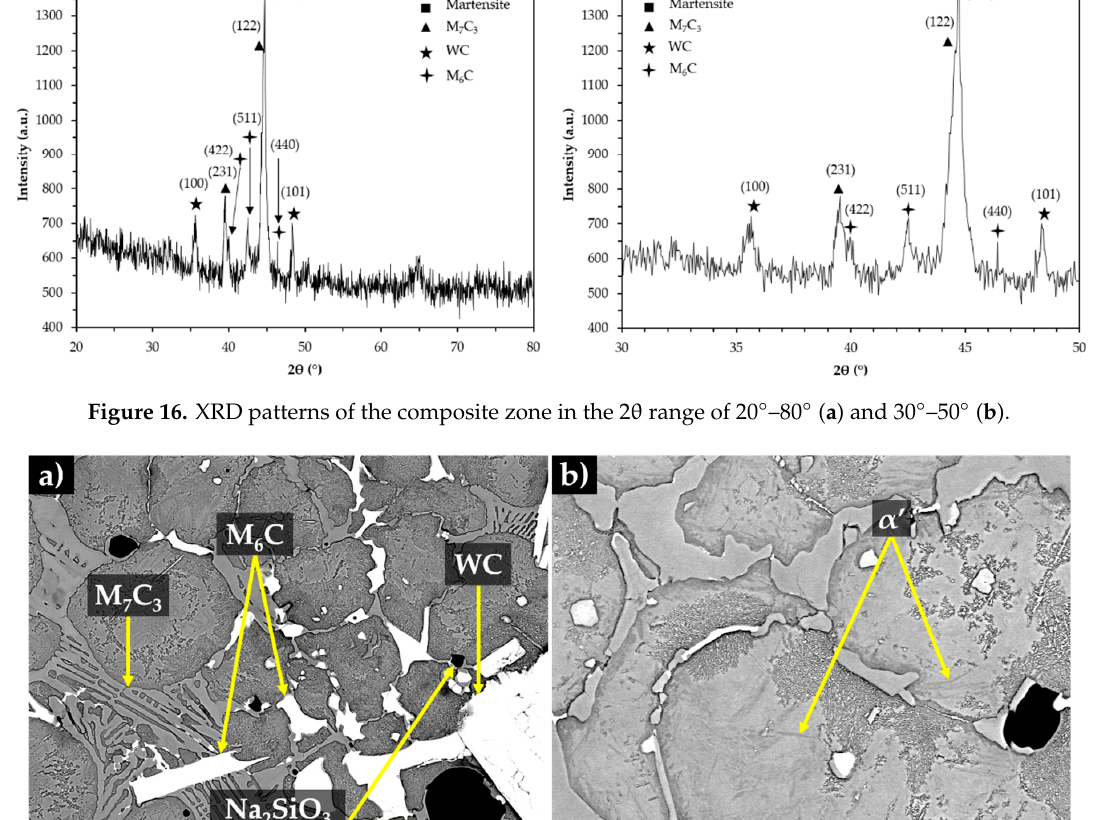
Figure 19. Dark-field TEM image of the composite showing ( a ) an interface between (Fe,W,Cr) 6 C carbide and α ’ phase and ( b ) an M 23 C 6 carbide embedded in α ’. The identification of phases was performed by SAED analysis with ( c ) [112] zone axis of (Fe,W,Cr) 6 C and ( d ) [100] zone axis of α ’ and [110] zone axis of M 23 C 6 . 4. Conclusions High-Cr WCI specimens locally reinforced with WC–metal matrix composites were successfully produced via an ex-situ technique, using powder mixtures of WC and Fe and Na 2 SiO 3 as a binder.